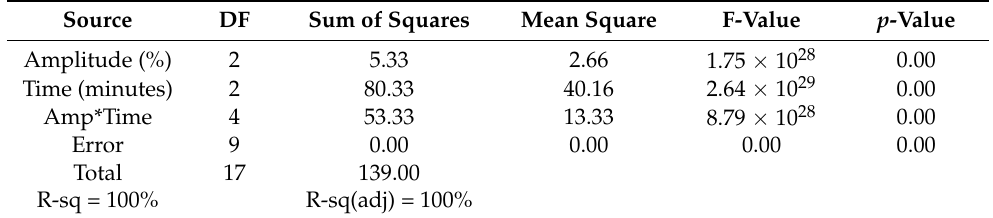
Table 4. ANOVA analysis for tensile strength (CS).